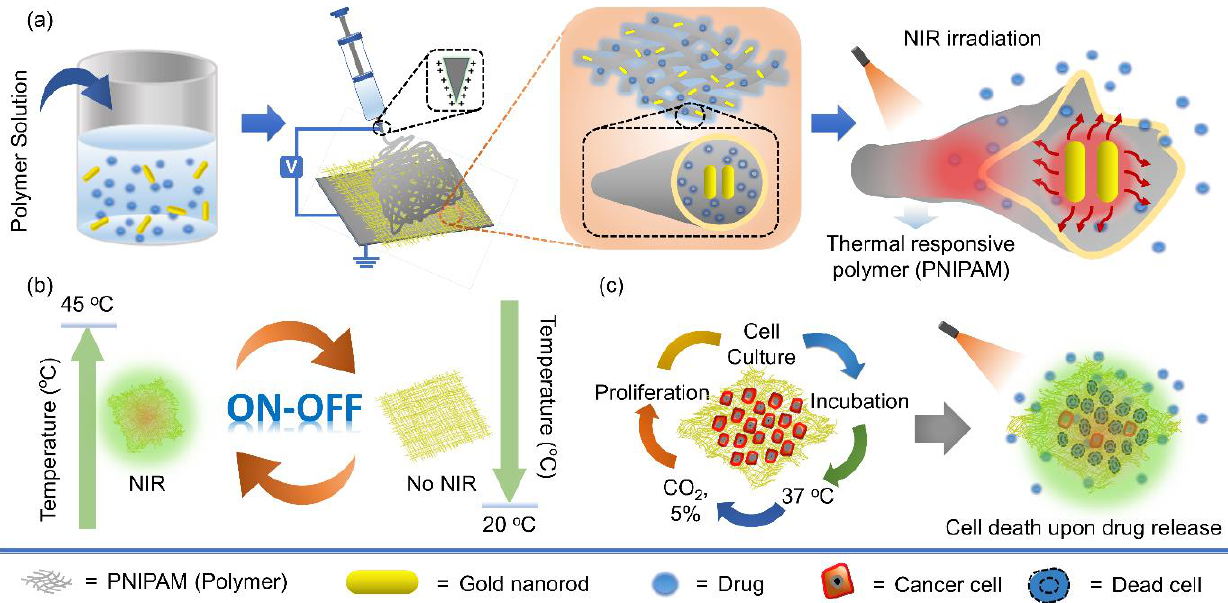
Scheme 1. Schematic illustration of stimuli-responsive nanofibers containing GNRs for on-demand drug delivery platform. ( a ) Fabrication of nanofiber through electrospinning technique and drug release upon NIR irradiation. ( b ) On–off cyclic profile of the nanofibers. ( c ) Cell proliferation on the nanofibers and cell death upon drug release.